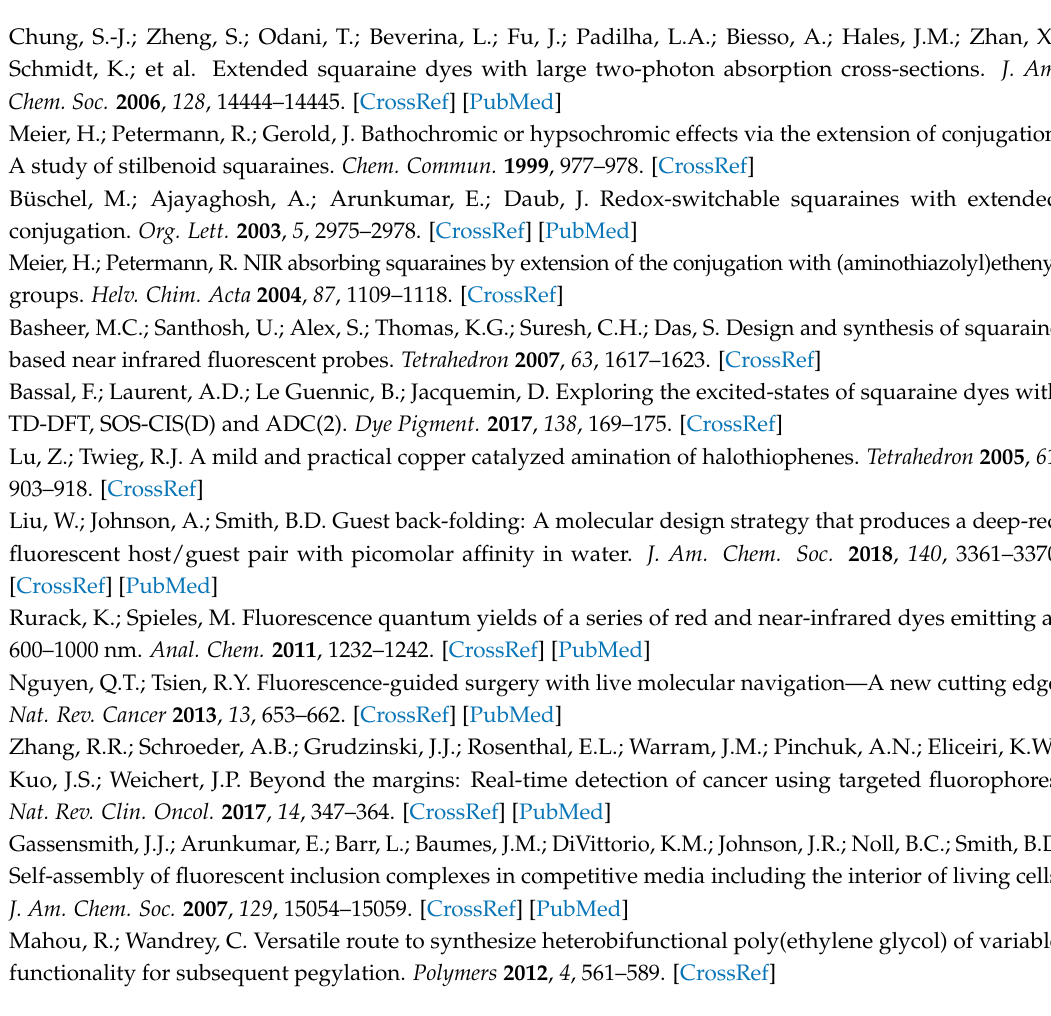
Sample Availability: Samples of the compounds S1 – S3 , S1PEG – S3PEG , M1 , and M2 are available from the